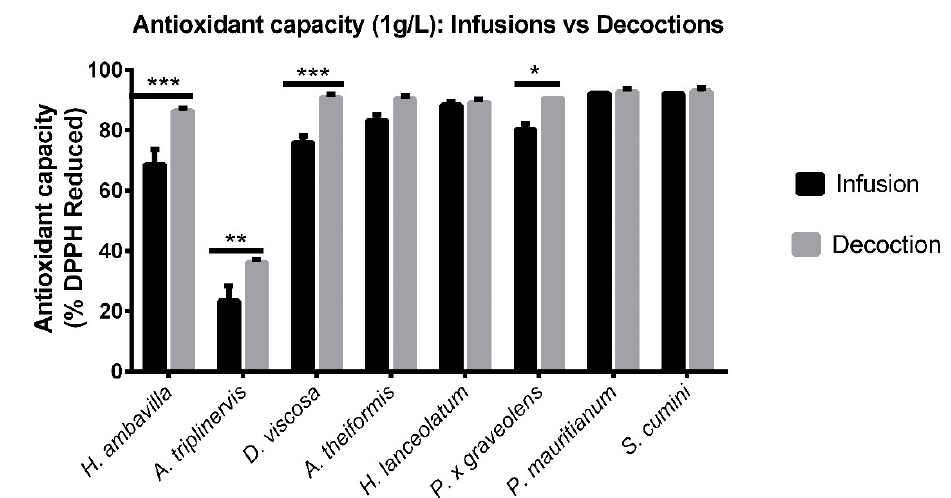
Figure 3. DPPH assay comparing infusion and decoction modes based on traditional preparation (1 g dry powder/L). Data are means ± SEM of three independent experiments. * p < 0.5, ** p < 0.01, *** p < 0.005 as compared to